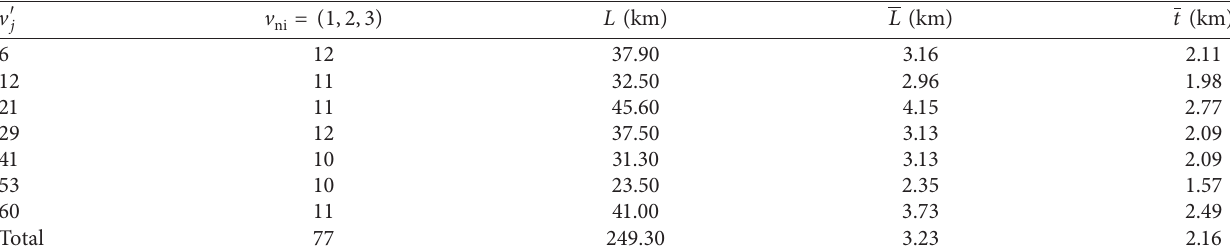
Table 2: Average lengths of the maintenance paths and arrival times.